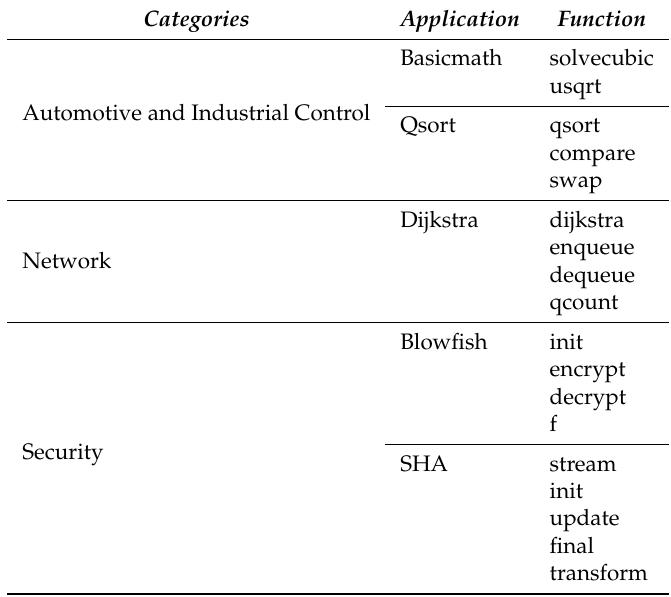
Table 4. Benchmarks of MiBench selected as experimental